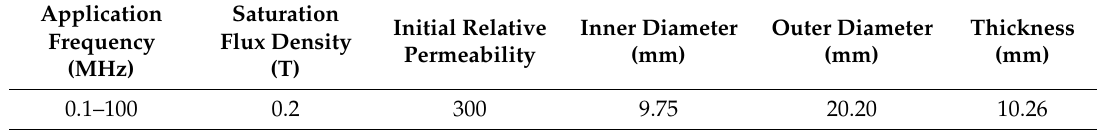
Table 4. Parameters of the Ni–Zn ferrite core.